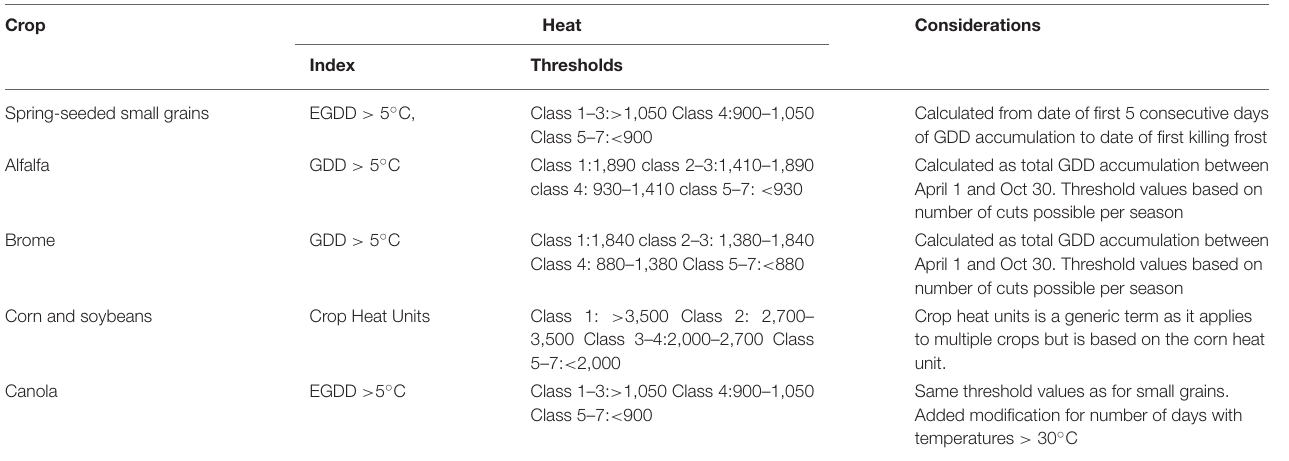
TABLE 4 | Heat indices and thresholds used in the LSRS crop